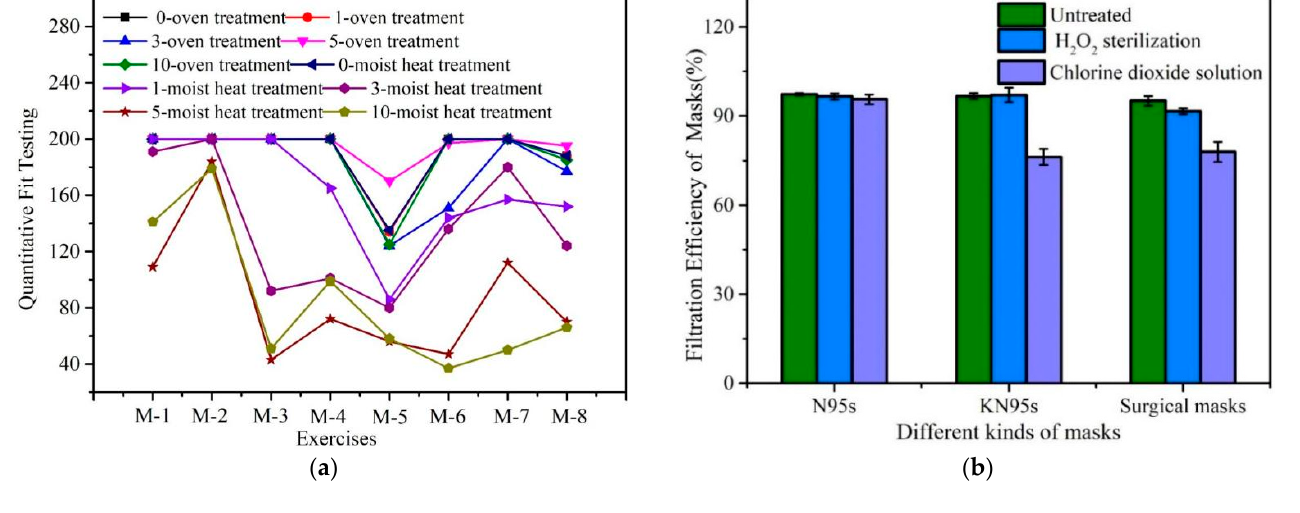
Figure 4. Fitness and decontamination research on filtration efficiency: ( a ) quantitative fit testing results for the new N95 respirator and after oven and steam heat-treatment cycles; M-1-M-8 represent normal breathing, deep breathing, head side to side, head up and down, talking, bending over, normal breathing, and overall fit factor, respectively [103]; ( b ) filter efficiency of mask after hydrogen peroxide and chlorine dioxide decontamination [102].